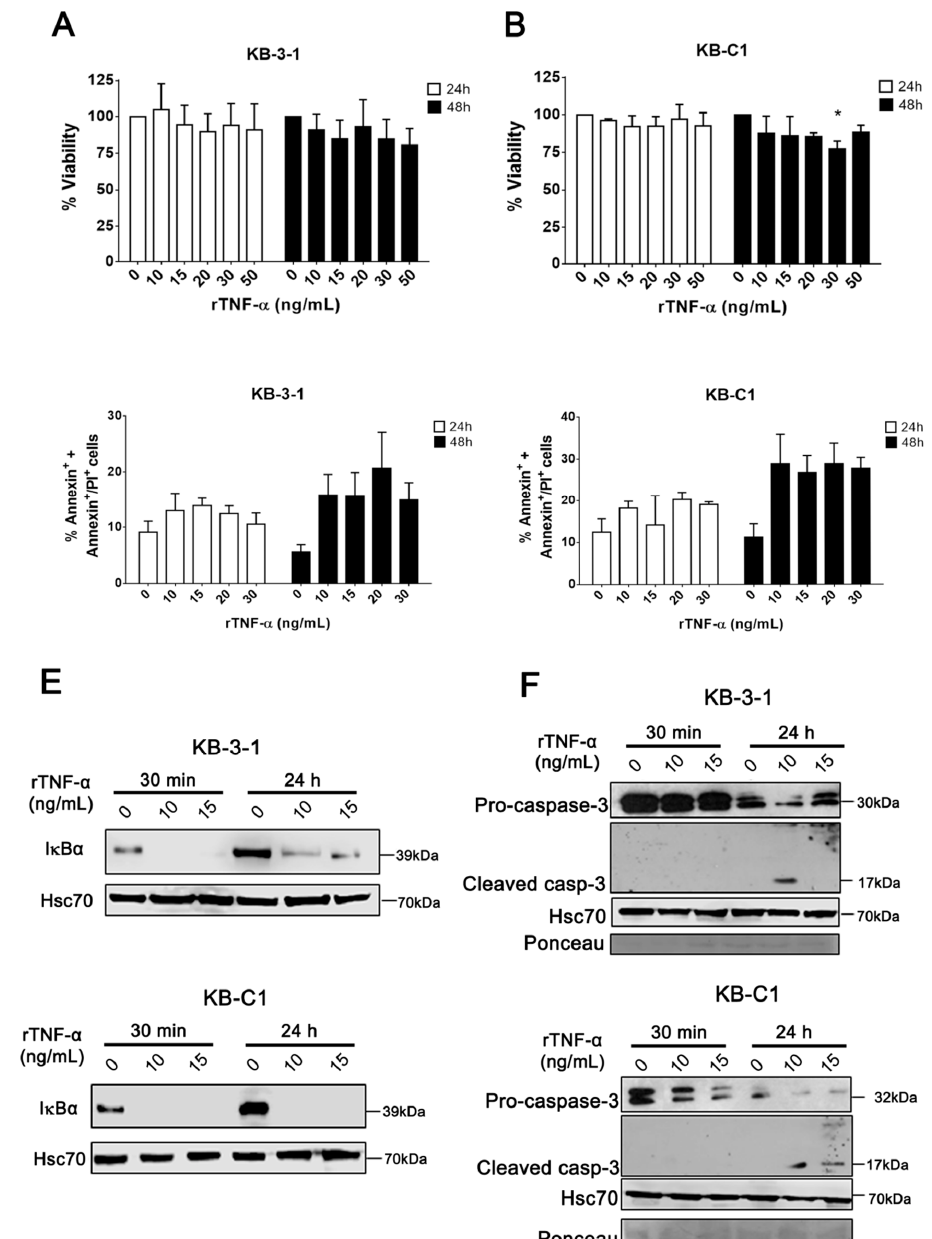
Figure 1. Analysis of parental and multidrug resistance (MDR) cell viability after recombinant human tumor necrosis factor-alpha (rTNF- α ) treatment. Cell viability determined by ( A , B ) MTT assay and ( C , D ) annexin-V positive staining after 24 or 48 h of rTNF- α treatment in di ff erent concentrations. Immunoblot analysis of ( E ) I κ B α , ( F ) pro-caspase-3 and cleaved caspase-3 protein levels determined after 30 min or 24 h of 10 or 15 ng / mL rTNF- α treatment. Data are means ± SD of three independent experiments. One-way ANOVA with Dunn’s posttest and t -tests were used to analyze the MTT assay and annexin-V staining results, respectively. * p < 0.05 indicates the statistical significance of